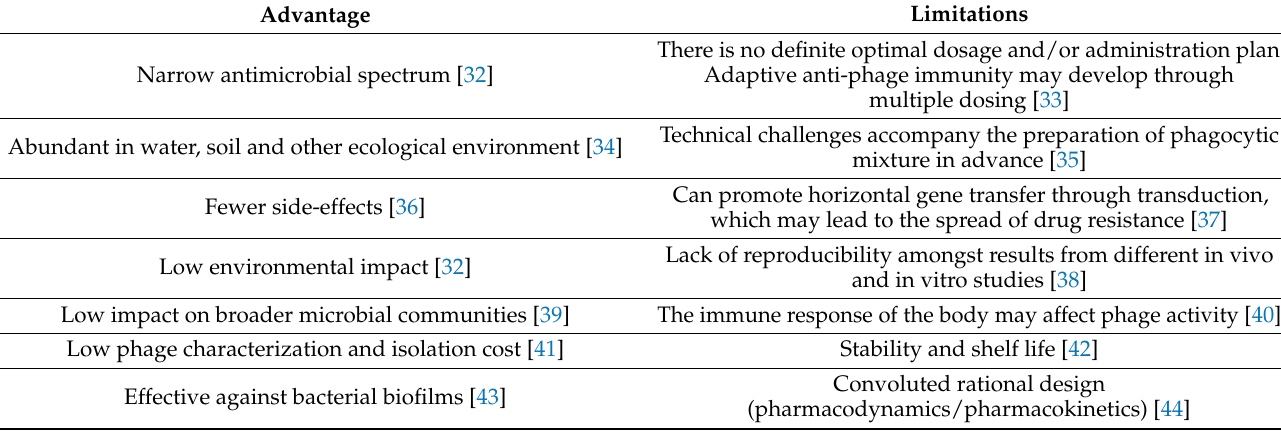
Table 1. Advantages and limitations of phage therapy in comparison to